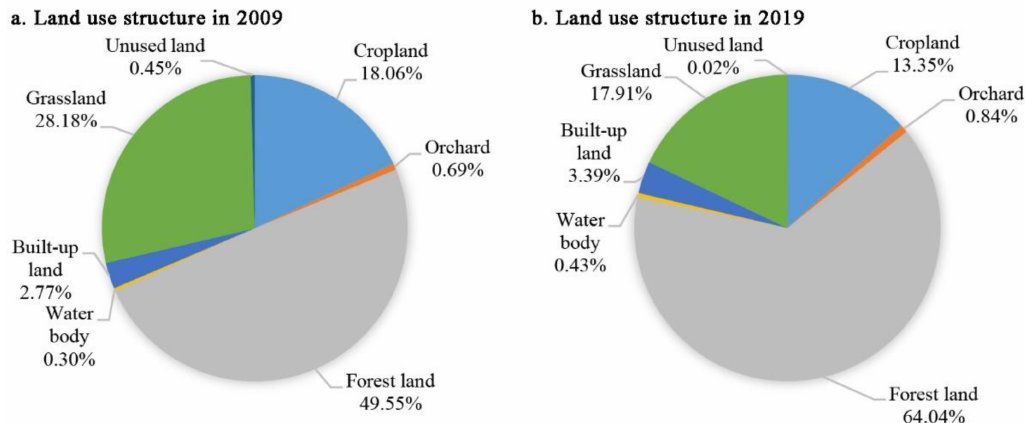
Figure 4. Changes of land use structure in Pu County between 2009 and 2019.